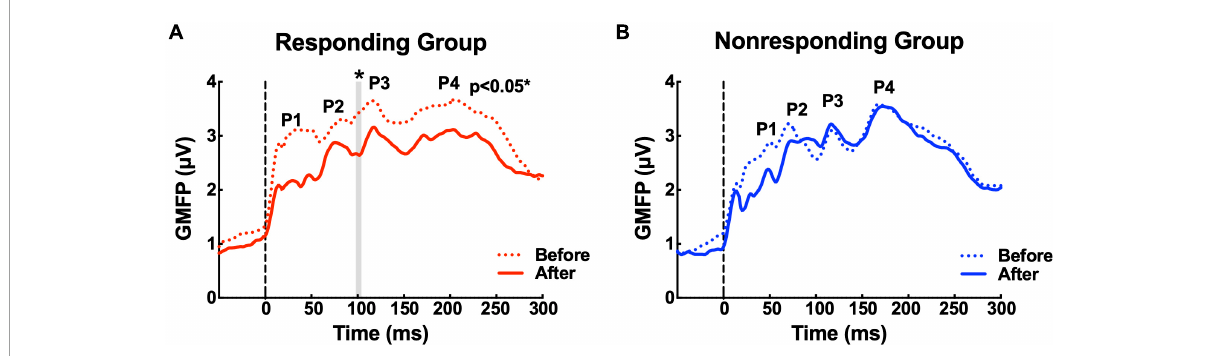
FIGURE2 The waveforms of the global mean field power (GMFP) before and after multidisciplinary intensive rehabilitation treatment (MIRT). (A) The solid and dashed red curves depict GMFP in the responding group before and after MIRT. The gray shaded area shows a significant difference in GMFP amplitude before and after MIRT in the responding group. * p < 0.05 with correction. (B) The solid and dashed blue curves depict GMFP in the non-responding group before and after MIRT.